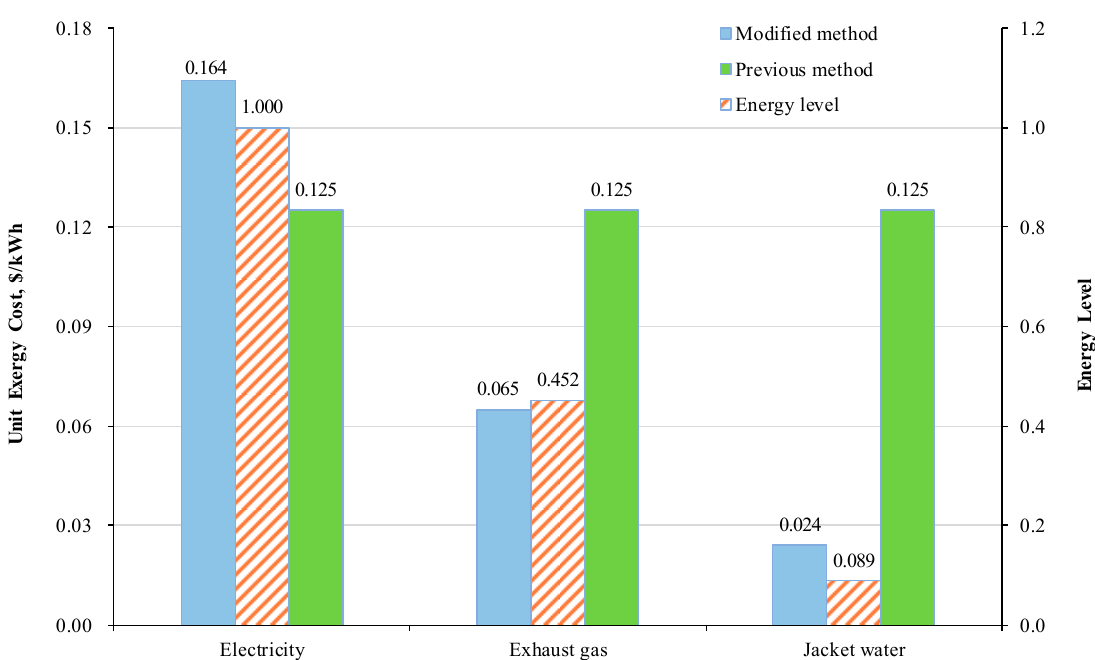
Figure 4. Unit cost of internal combustion engine under two economic methods.